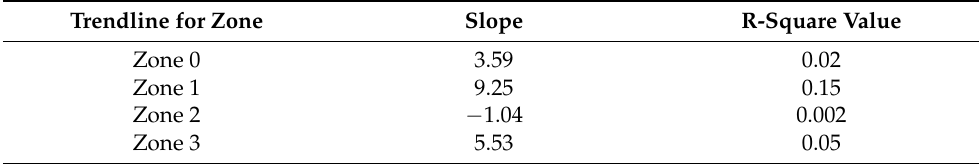
Table 11. Mann-Kendall Trend Test When Combined Criteria are Considered.